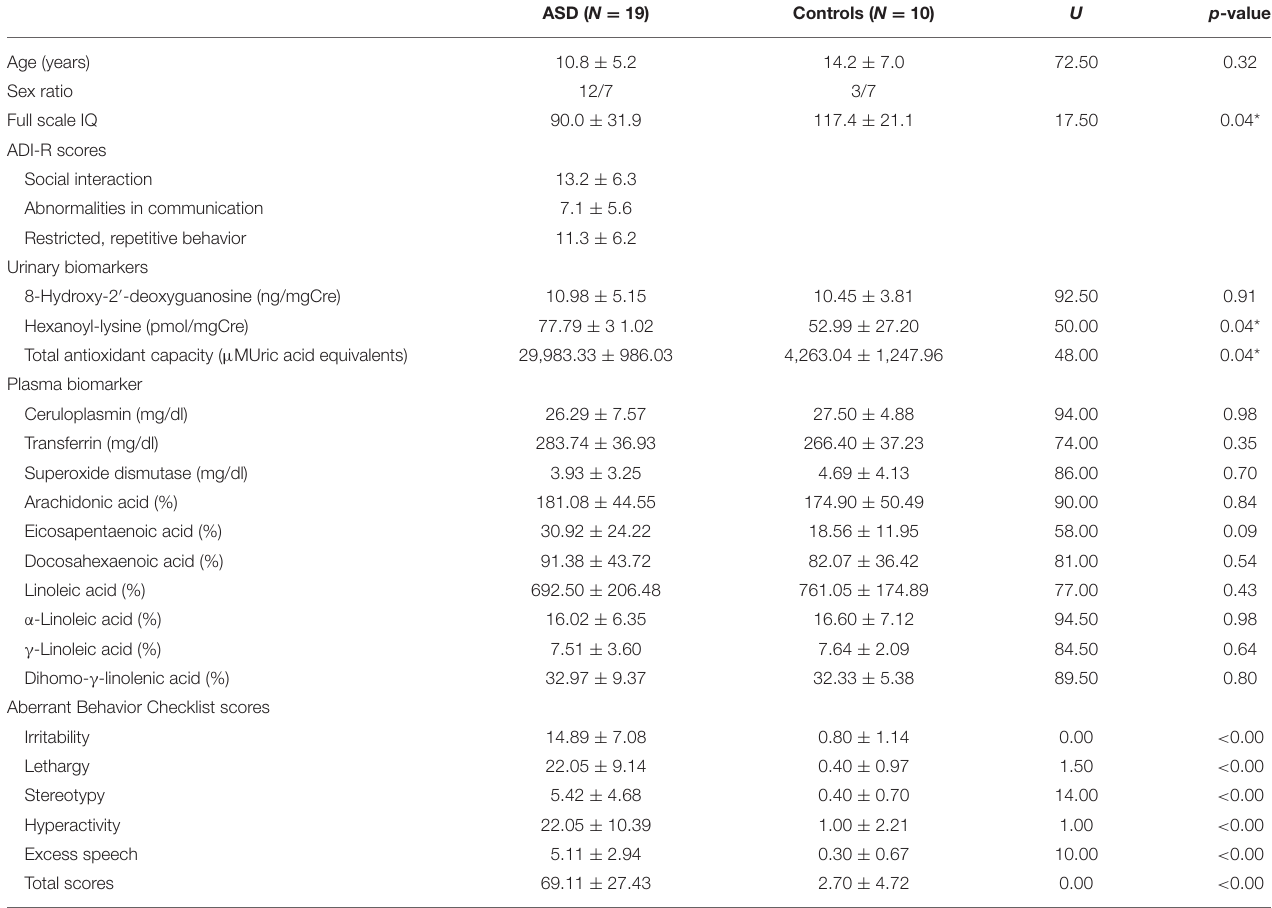
TABLE 1 | Clinical characteristics and urinary and plasma variables, and ABC scores in ASD control